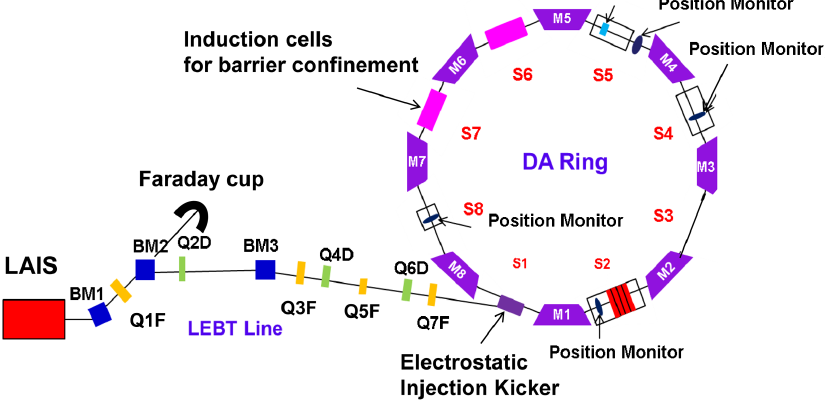
FIG. 1. Schematic view of the KEK-DA integrated with the LAIS.